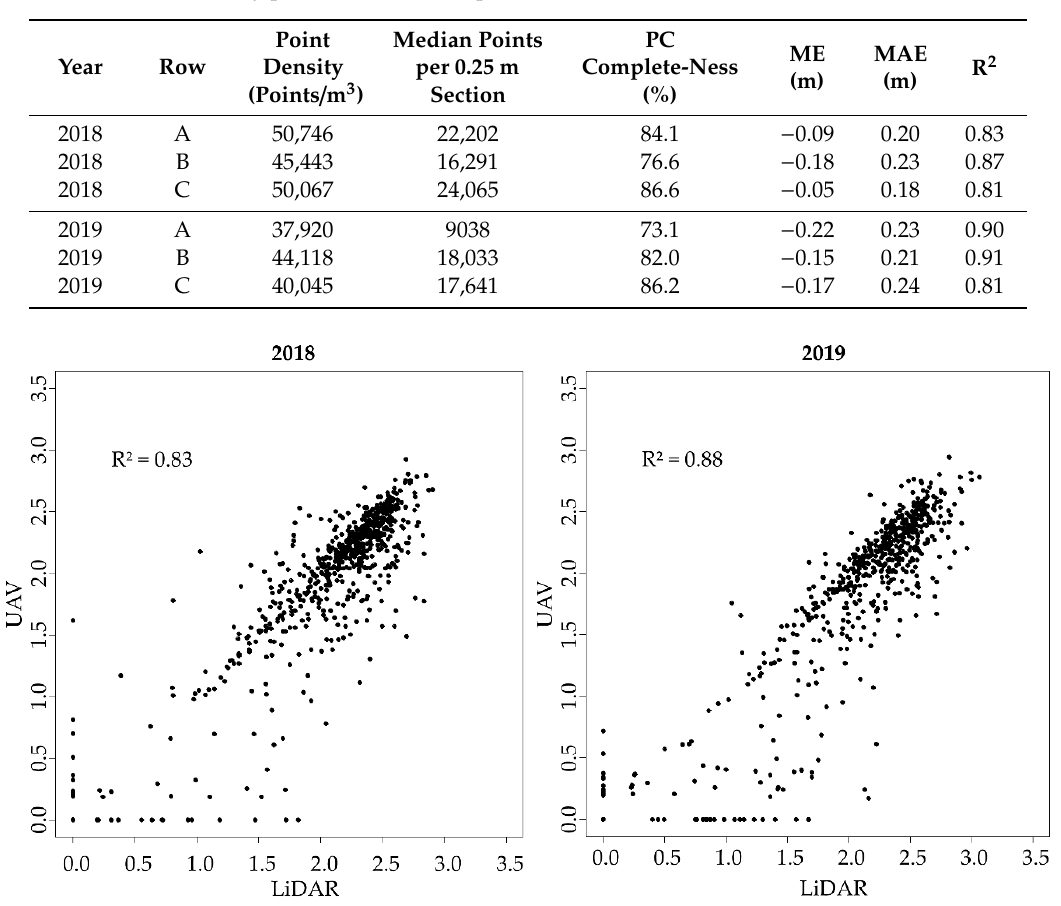
Table 1. Quality parameters for UAV point clouds of tree rows A, B, and C in 2018 / 19.